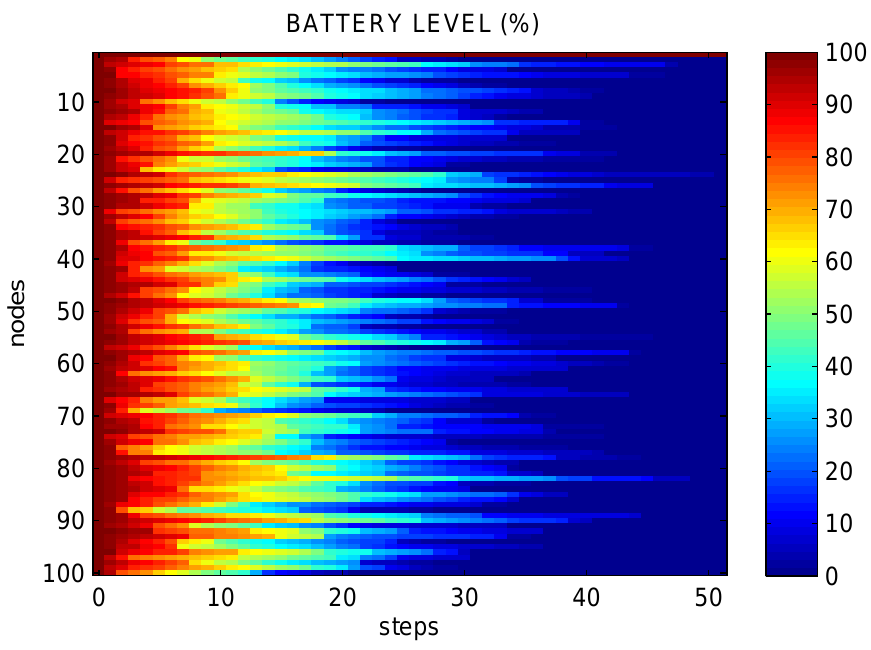
Figure 4. Battery level status for each sensor during iterations of the simulated 100-nodes network (average results over 10